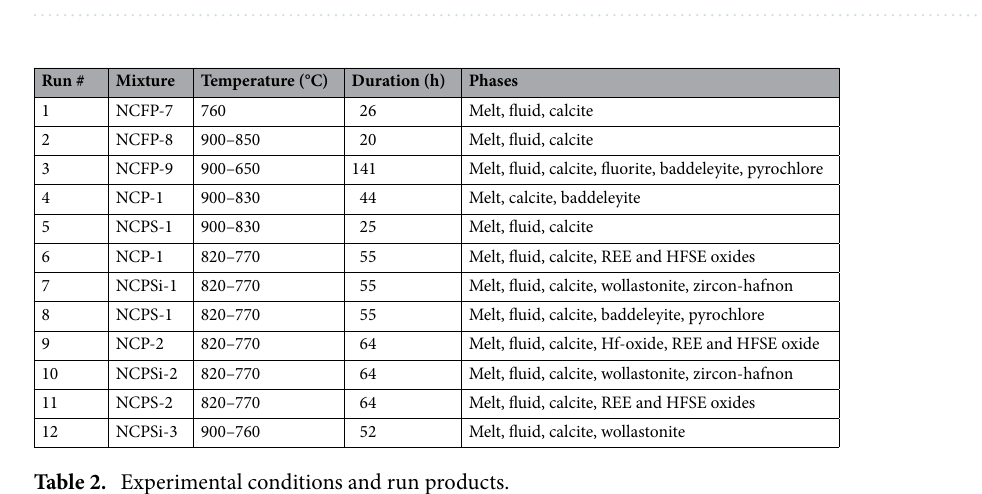
Figure 2. Textures of the experimental samples: ( a ) #3 NCFP-9; ( b ) #4 NCP-1; ( c ) #6 NCP-1; ( d ) #7 NCPSi-1.